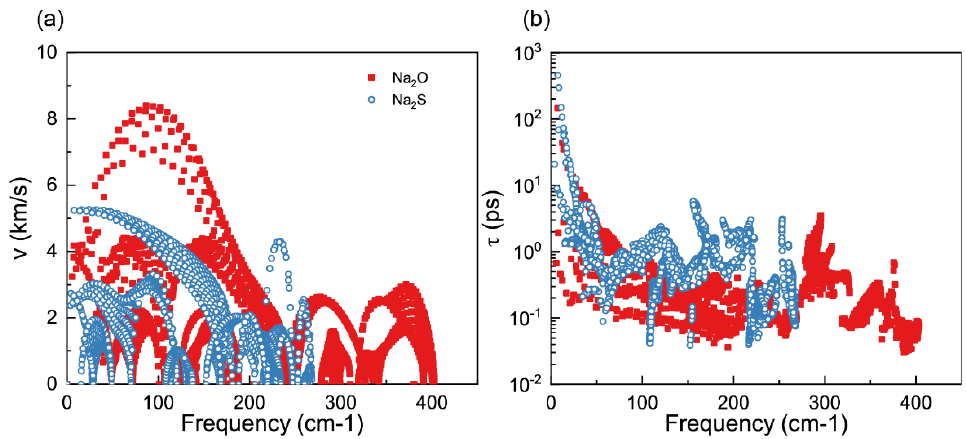
Figure 4. The ( a ) group velocity and ( b ) phonon relaxation times for Na 2 O and Na 2 S monolayers at room temperature.